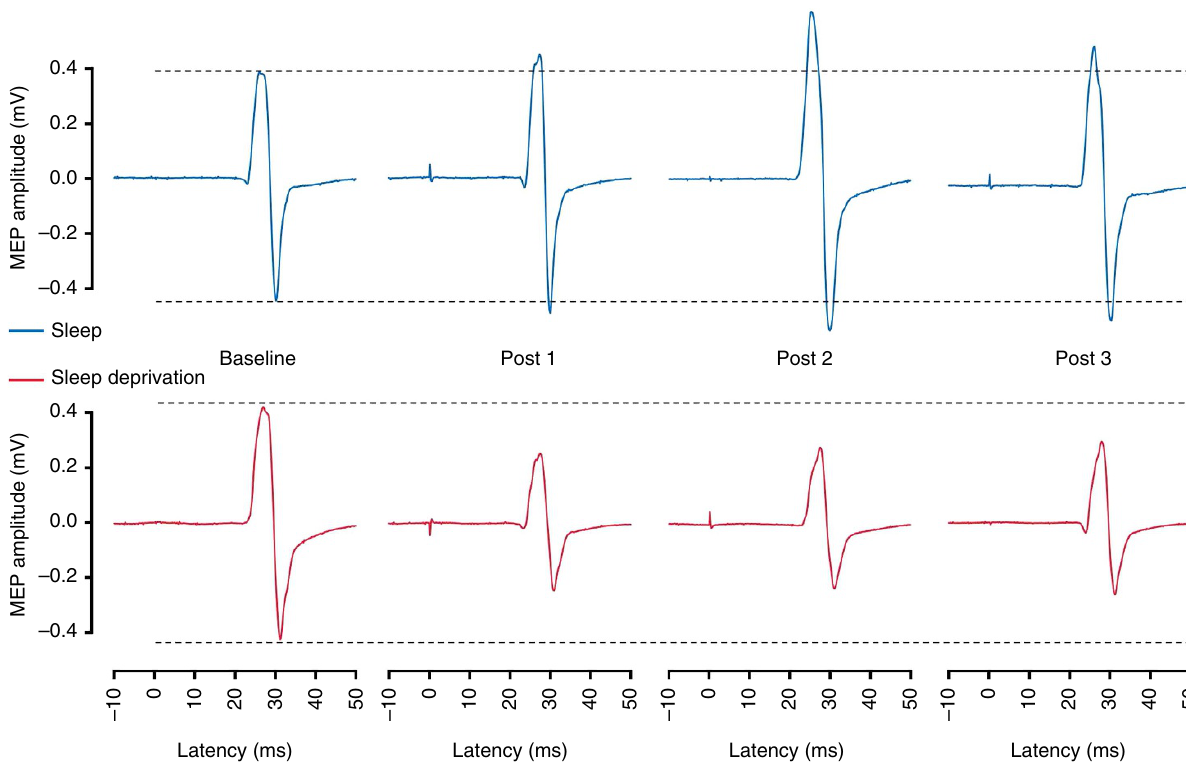
Figure 7 | Raw examples of single motor-evoked potentials (MEPs). Single MEPs of one participant were selected to illustrate the results. MEP amplitudes increased from baseline level after paired associative stimulation (PAS) in the sleep condition, whereas MEP amplitudes decreased from baseline level after PAS in the sleep deprivation